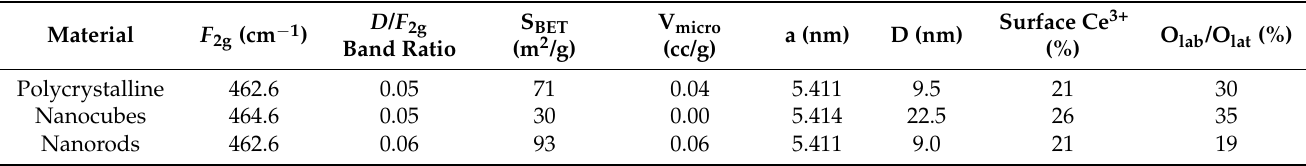
Table 1. Physicochemical characterization results for the nano-shaped ceria materials extracted from Raman spectroscopy, N 2 physisorption isotherms, X-ray diffraction and X-ray photoelectron spectroscopy (XPS). Material